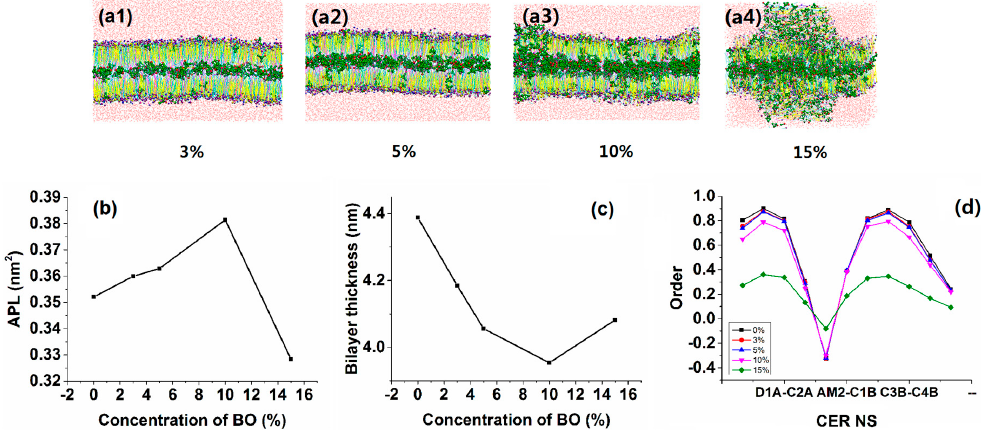
Figure 1. Morphologies and corresponding analyses of lipid bilayer systems at different borneol concentrations by CG-MD simulations: ( a ) morphologies of the lipid bilayer at (1) 3%, (2) 5%, (3) 10% and (4) 15% of borneol; ( b ) APL analysis; ( c ) bilayer thickness analysis; and ( d ) order parameter analysis for CER NS.